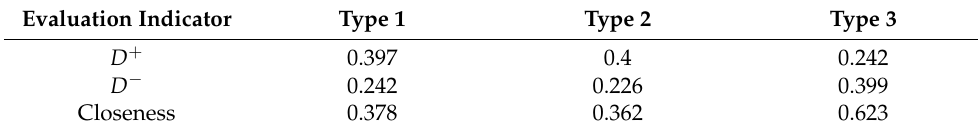
Table 12. Closeness results for the three